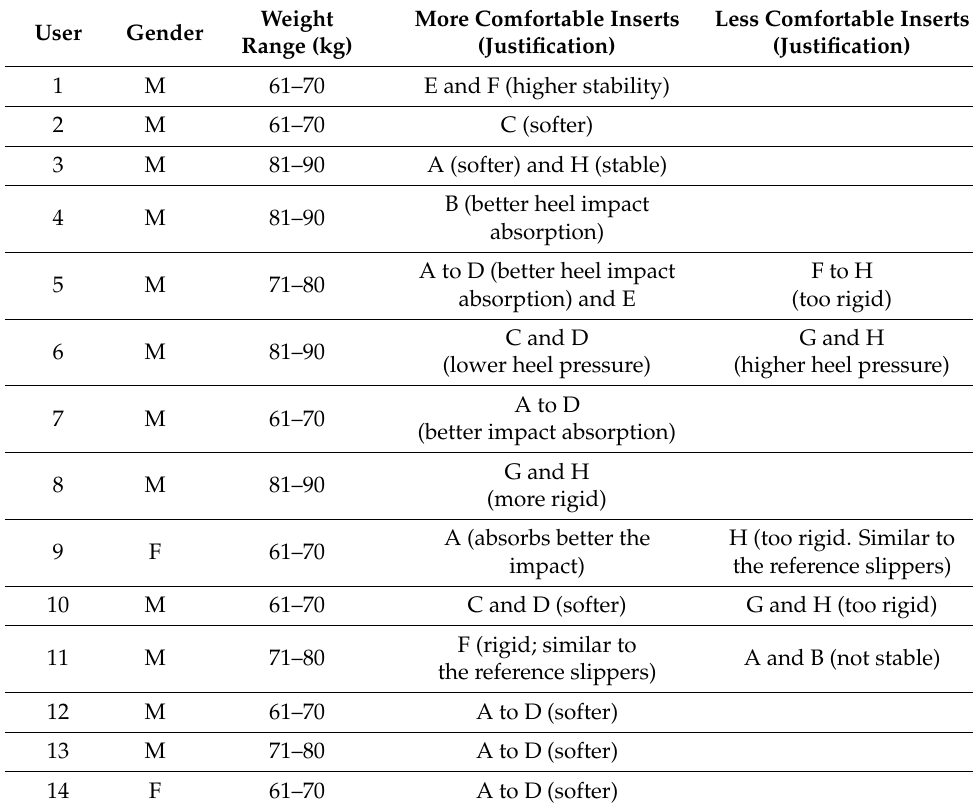
Table 3. Information collected in the tests performed by a panel of